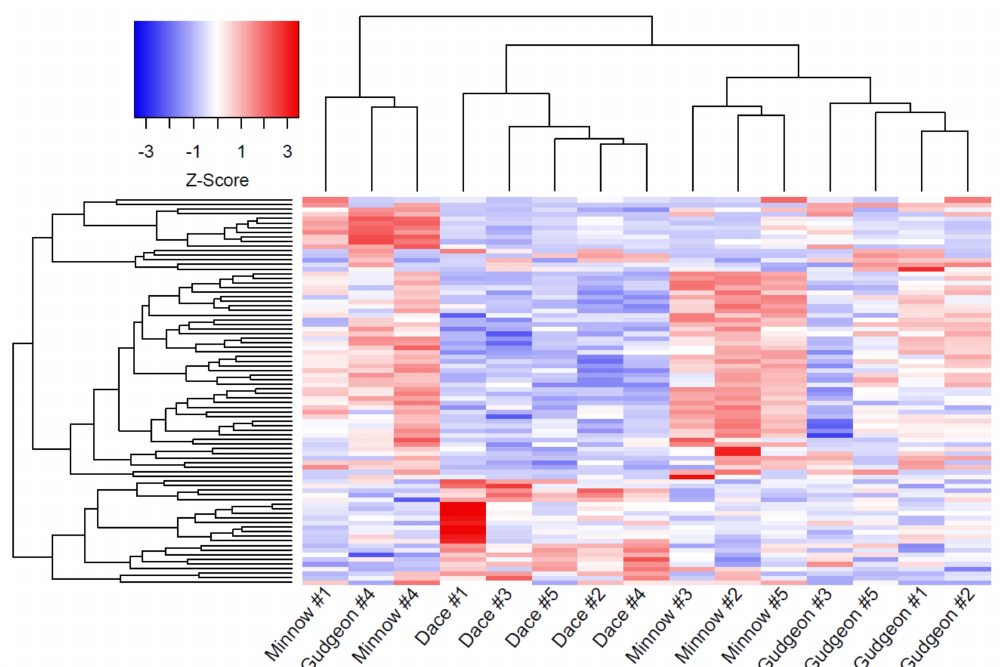
Figure 2. Heat map synthetizing gene expression profiles (higher Z-score refers to higher expression) according to a clustering approach based on the different 84 differentially expressed genes found in parasites sampled on different host species (dace, minnow and gudgeon, respectively). Genes are displayed on the y -axis, while samples (parasites) are displayed on the x -axis. Each parasite sample is named by the name of host species from which it was sampled (five parasite samples per host species).